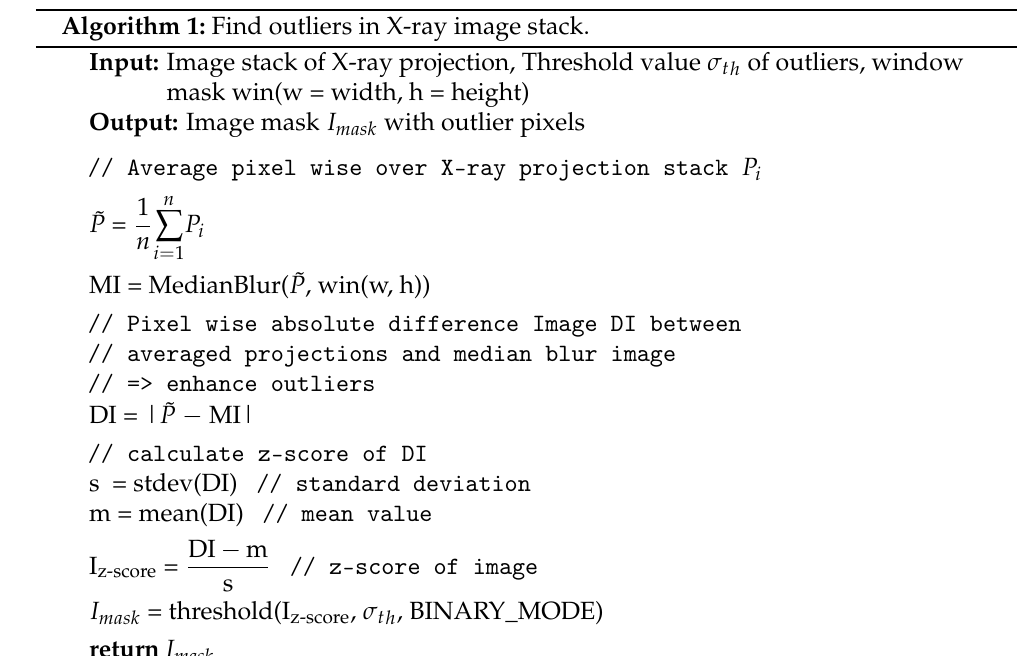
Algorithm 1: Find outliers in X-ray image